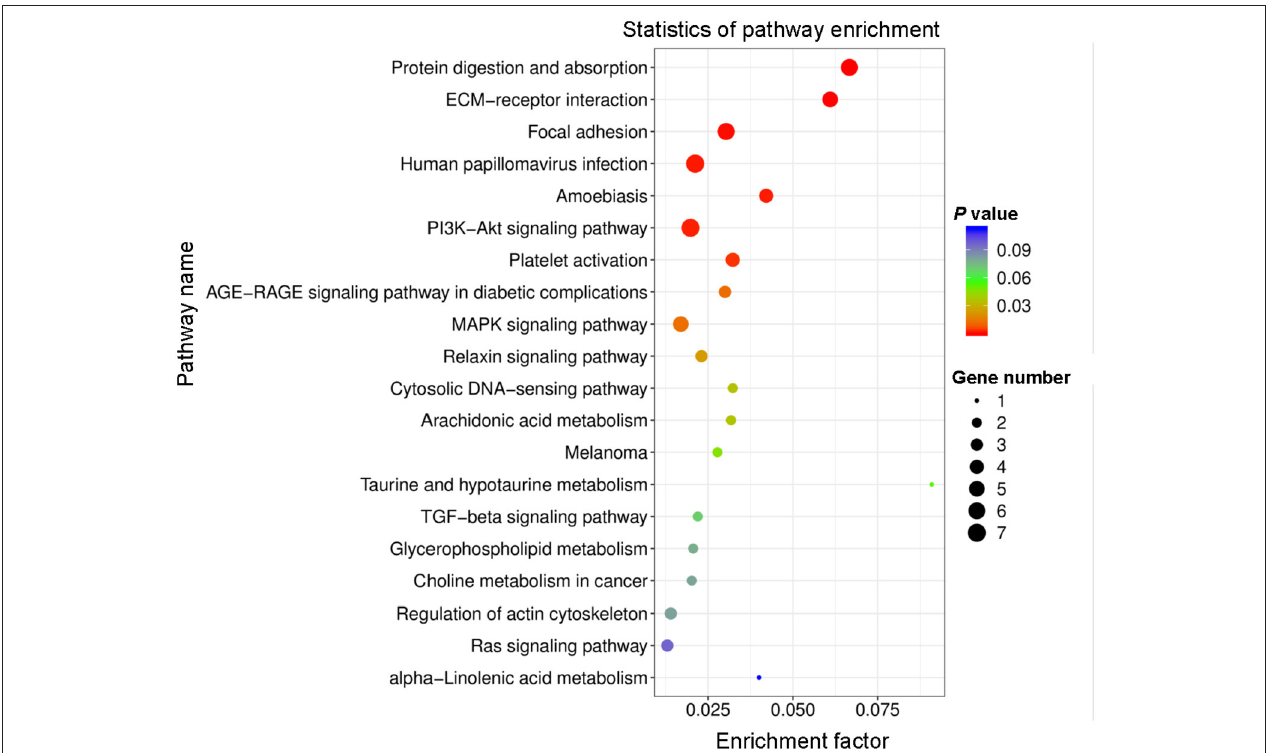
FIGURE 4 | Top 20 enriched Kyoto Encyclopedia of Genes and Genomes (KEGG) pathway terms of differentially expressed genes (DEGs). Rich factor represents the percentage of DEGs in the KEGG relative to the identified genes in that classification. Circle size and color indicate the number of genes and P -value,